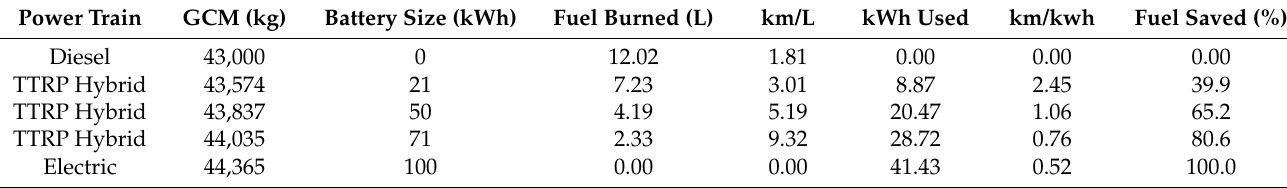
Table 6. Drive cycle 1 results.